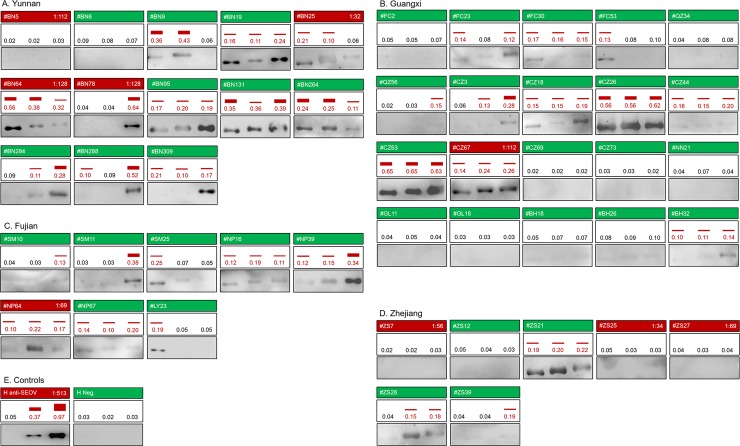
Serological results of 48 bat sera and 2 control human sera.Bat sera in four provinces: (A) Yunnan (n = 13), (B) Guangxi (n = 20), (C) Fujian (n = 8) and (D) Zhejiang (n = 7). (E) two human sera as positive (H anti-SEOV) and negative (H Neg.) serum controls. Each square represents one serum, consisting of upper (FAVNT), middle (ELISA) and lower (WB) rectangular boxes indicating the assay method. Numbering of each sample is to the left of the FAVNT box. FAVNT positive sera are noted in red, with the titer on the right, while the negatives are in green (no titer). In the ELISA box, the OD492 value against the rNP of LAIV, XSV and SEOV are shown from left to right with the positive titers in red and negatives in black (no bar). In the WB box, 0.2 μg/lane rNP of LAIV, XSV and SEOV were separately loaded from left to right.